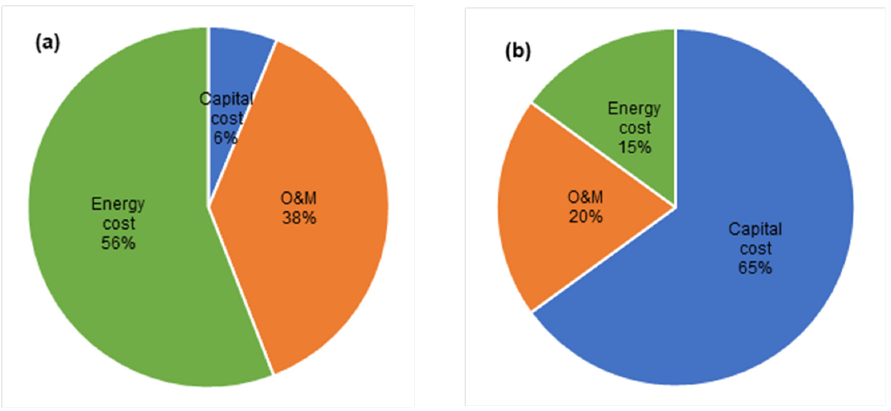
Figure 6. Cost comparison per energy source for the industrial BWRO desalination plants. ( a ) Electricity network; ( b ) PV solar energy.